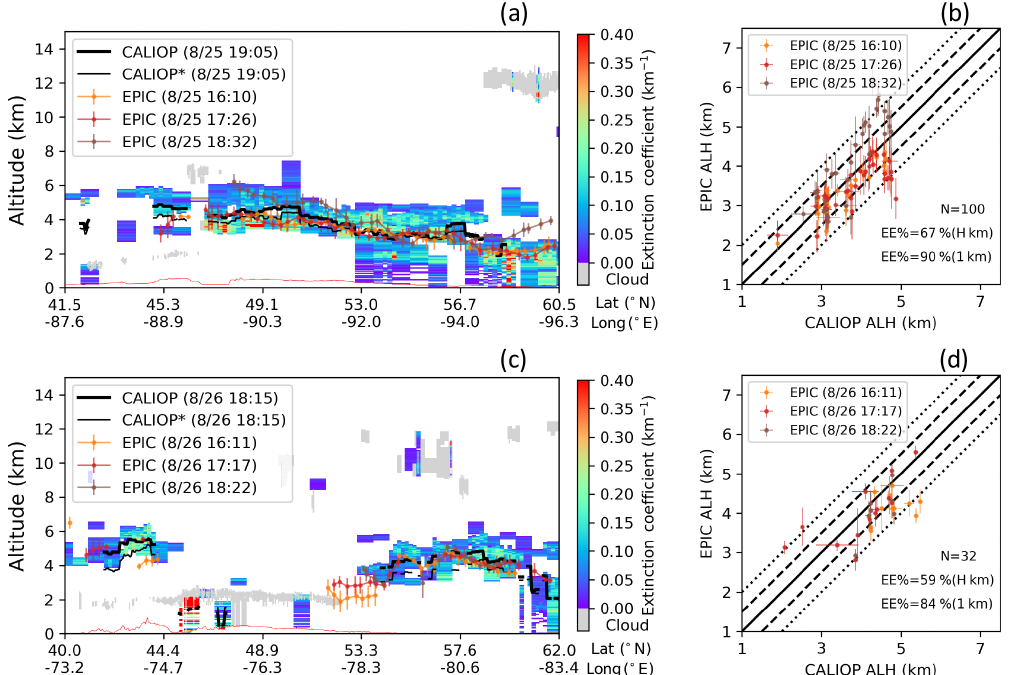
Figure 9. Comparison of ALH retrieved from EPIC and CALIOP level 2 aerosol extinction profile in both “curtain” view (a, c) and “scatter- plot” view (b, d) for 2d overpasses. The CALIOP orbital tracks are marked on EPIC RGB images in Figs. 7–8. Different EPIC scan times are marked with different line and symbol colors in the comparison. The error bar for EPIC ALH represents the standard deviation for an array of 3 × 3 24km retrieval pixels, while that for CALIOP ALH represents the standard deviation of over five adjacent CALIOP 5km footprints. Also shown in panels (a, c) is the CALIOP* ALH (thin black curve) calculated with a background aerosol profile imposed for undetected aerosol layers (see text for detail), whereas the bold black curve represents the CALIOP ALH without considering background aerosol.